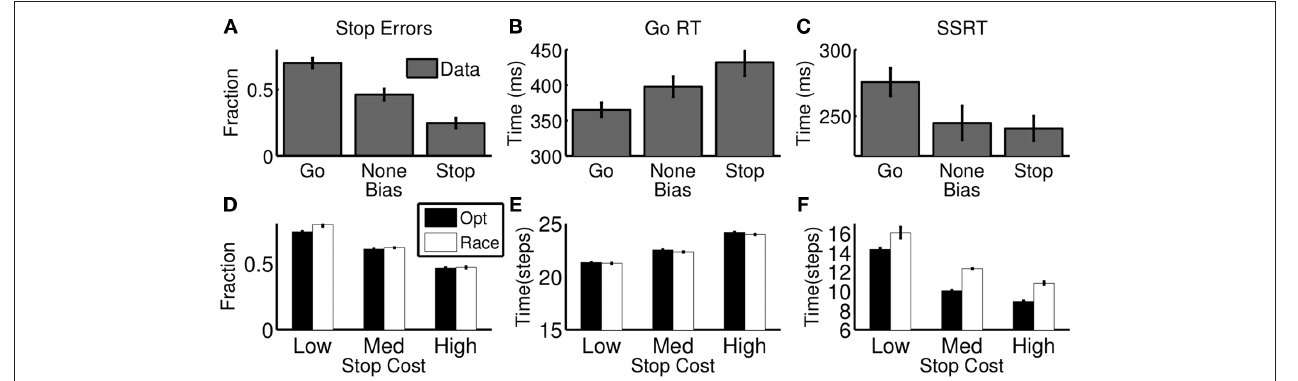
the start of the diffusion process increases (C) , and SSRT decreases (D) ; rate and threshold parameters are unaffected (A, B) . Changes in SSRT are similar to those in optimal model and experimental data ( Figure 5 ). Each bar denotes average of 10 simulated “sessions,” each session consisting of 10,000 trials. Error bar